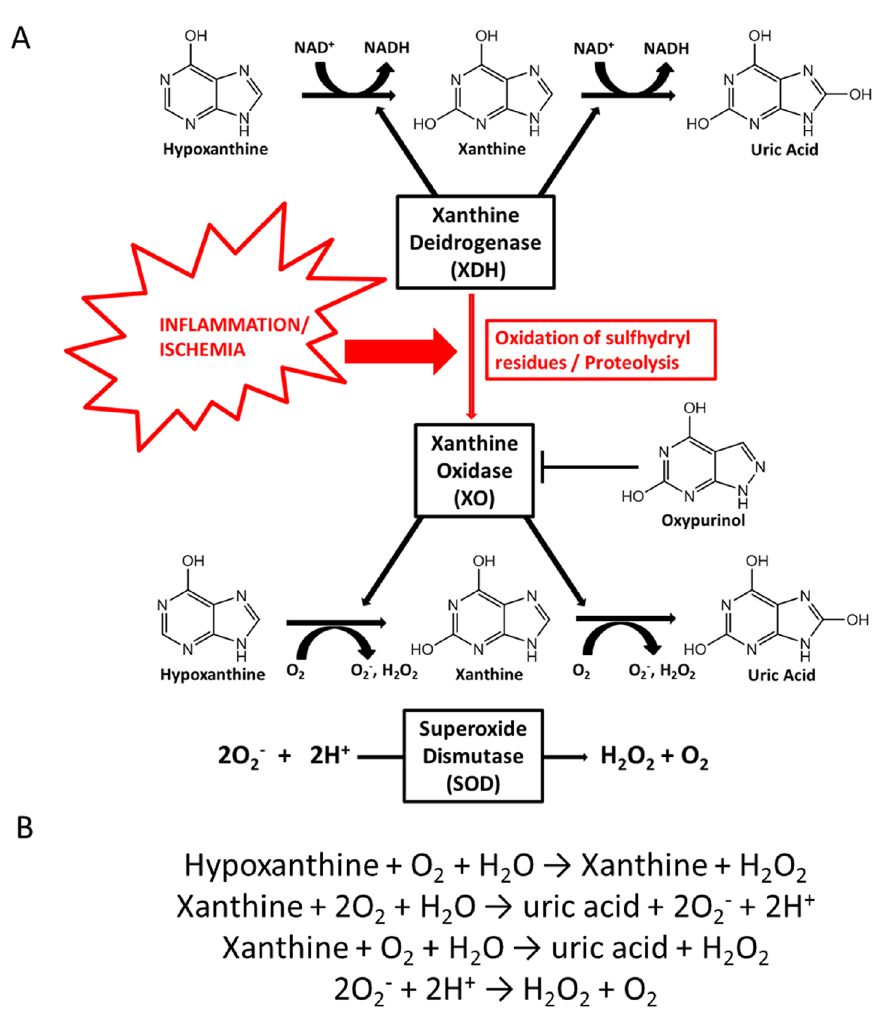
Figure 1. Uric acid formation through xanthine oxidase activity. ( A ) Under ischemic or inflammatory conditions, xanthine dehydrogenase (XDH) is converted to xanthine oxidase (XO) via the oxidation of sulfhydryl residues or proteolysis of XDH. In the presence of oxygen, XO catalyses the oxidation of hypoxanthine to xanthine and then to uric acid (UA), with consequent production of the superoxide anion (O 2 − ) and hydrogen peroxide (H 2 O 2 ). The competitive antagonist allopurinol is converted in the active form, oxypurinol, via XO activity, acting as an XO inhibitor; ( B ) During hypoxanthine conversion to xanthine and then UA, high levels of H 2 O 2 and O 2 − are produced and converted to O 2 and H 2 O 2 , spontaneously or in a reaction catalyzed by the enzyme superoxide dismutase (SOD).